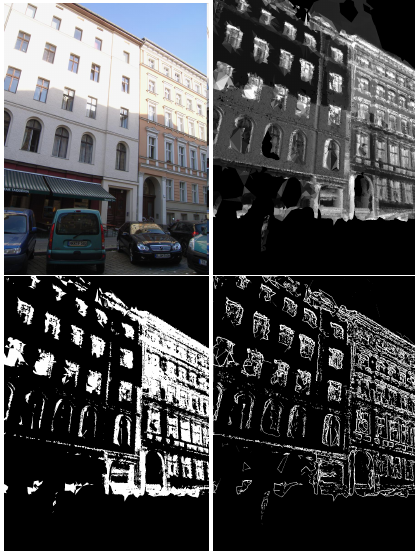
Figure 9. From top left to bottom right: fac¸ade image, visualiza- tion of colour differences to complete sequence, segmentation of colour difference image using the 0 . 7 quantile of pixels unequal 0 , image with gradient